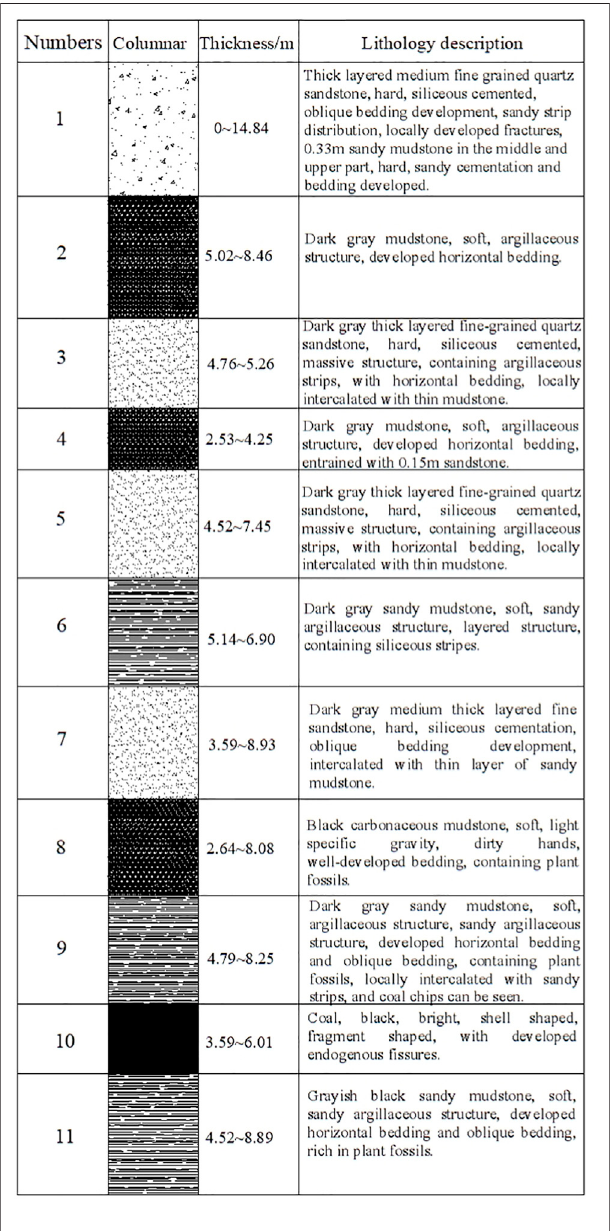
FIGURE 2 | Drilling histogram of the working face